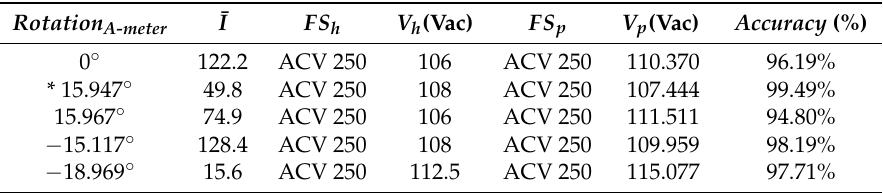
Table 5. Results of using A-meter YF-370A with function select “ACV 250” to measure the 110Vac line power. The mean accuracy was 97.28%.